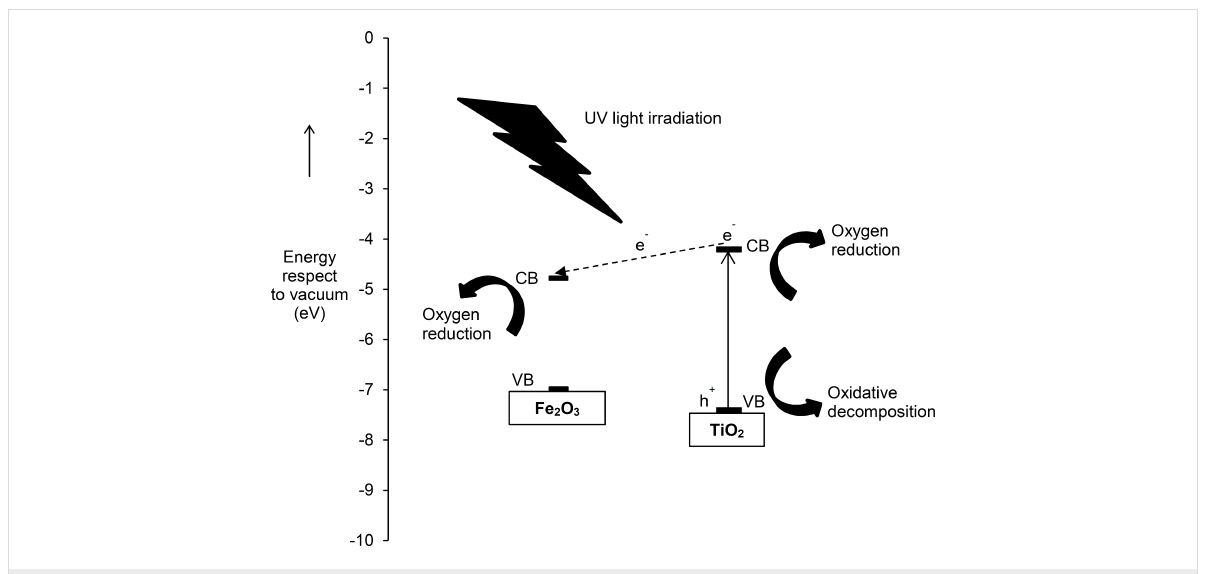
Figure 9: Proposed mechanism for major charge transfer pathways on Fe 2 O 3 (0.5)/TiO 2 (PD) for degradation of 2,4-D.